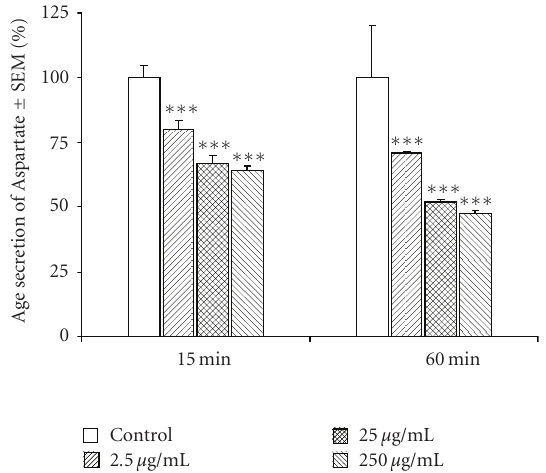
Figure 5: E ff ect produced by di ff erent concentrations (2.5, 25, and 250 μ g/mL) of methanolic extract of Nigella sativa on Aspartate release from cortical neurons. The cells were stimulated for 15 and 60minutes with each concentration. The values are expressed as a percentage of secretion with respect to basal value (100%). Statisti- cal significances were calculated with respect to the corresponding control at its respective time points: ∗∗∗ P < .